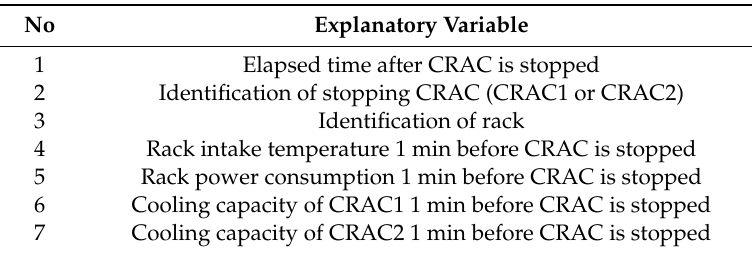
Figure 13. Image of blocks (case where only one CRAC is operating).